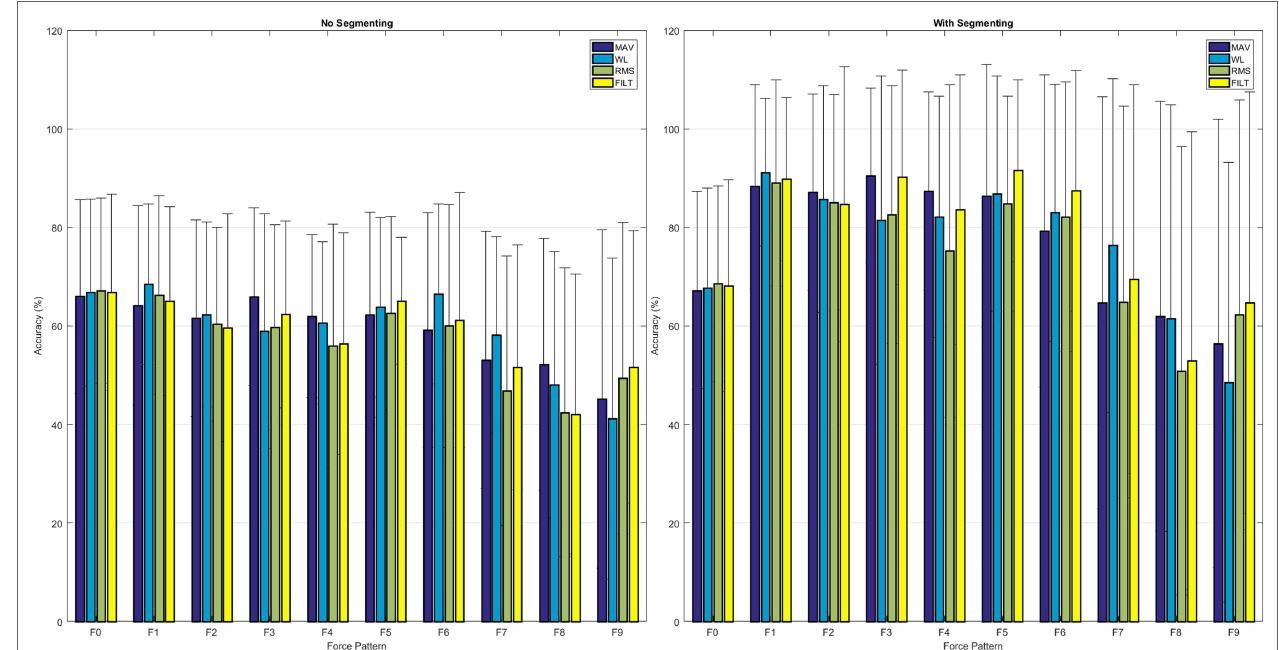
FIGURE 8 | Average classification accuracy for each individual force pattern, including rest, for each of the FEs: left, using the continuous data, right, using the segmented